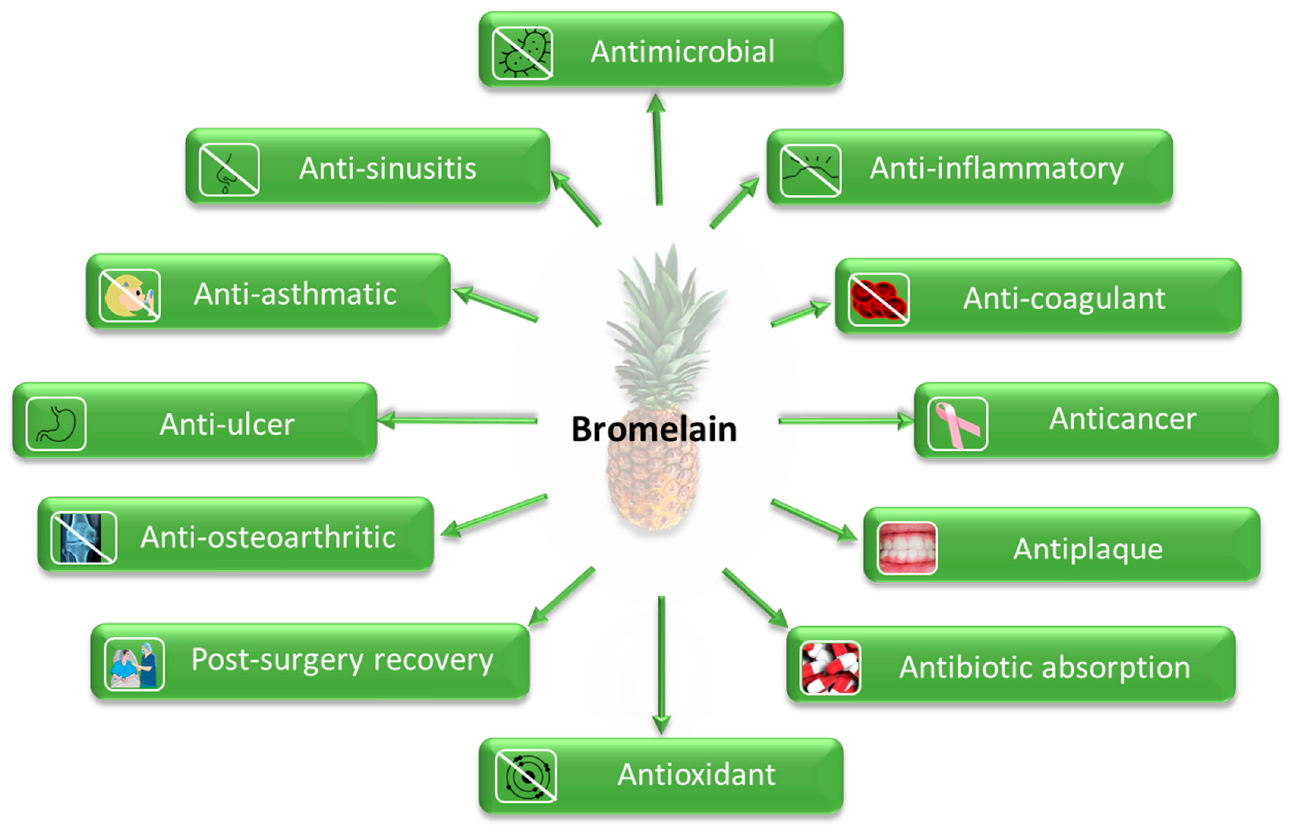
Figure 3. Overview of the bromelain bioactivity.